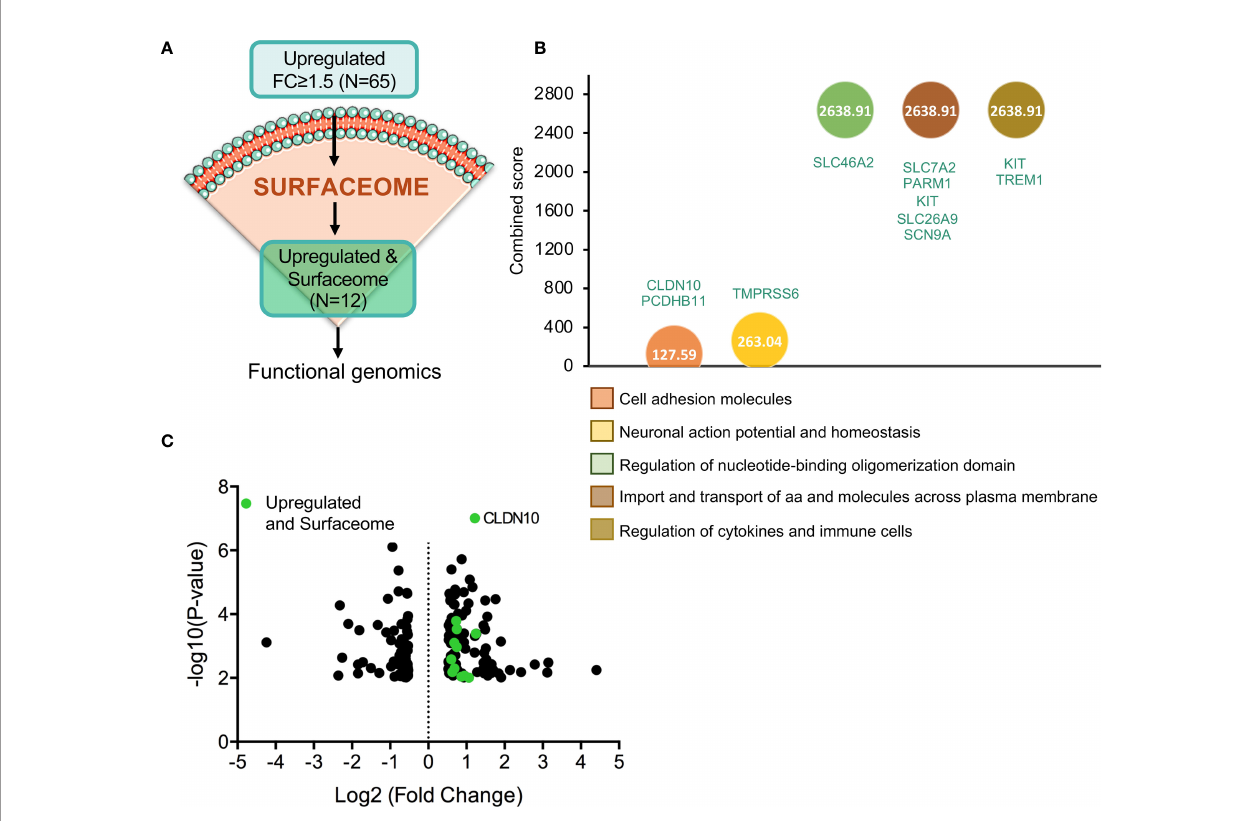
FIGURE 4 | Gene identi fi cation as cell-surface target candidates. (A) Flow chart of the process followed in order to identify those upregulated genes with fold change equal or higher than 1.5 (N=65) that codify for cell-surface proteins (N=12). (B) Identi fi cation of the biological processes with higher combine score in which the 12 selected genes are involved. (C) Volcano plot of statistic signi fi cant deregulated genes highlighted in green those that belong to